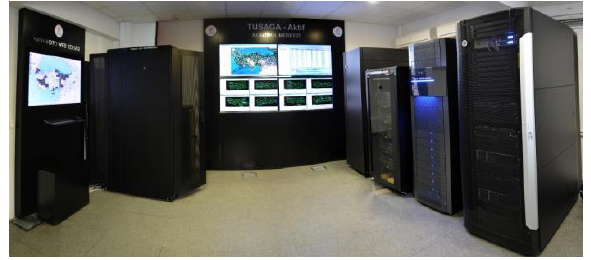
Figure 2. GDLRC CORS-TR Control